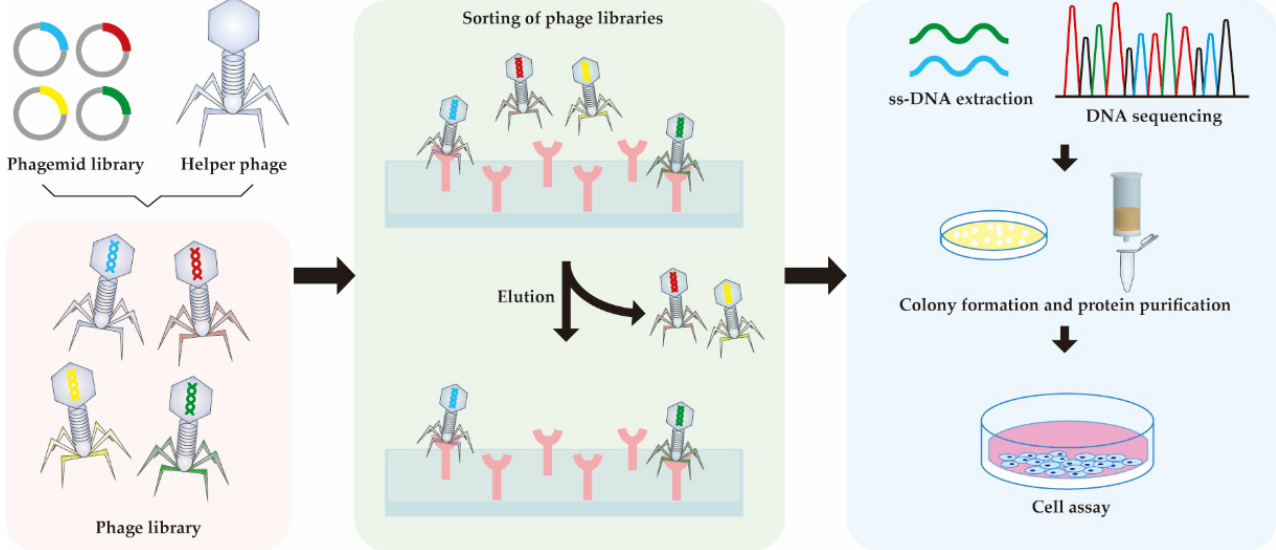
Figure 2. Workflow of phage display, which is used for the high-throughput screening of protein interactions. DNA encoding protein of interest are cloned into the genomes of multiple helper phages. The protein of interest, which is displayed on the phage surface, binds to the immobilized receptor. After the binding and elution steps, phages fractions with high binding affinities are collected and the DNA is sequenced. Amplification and purification are followed for further analysis.